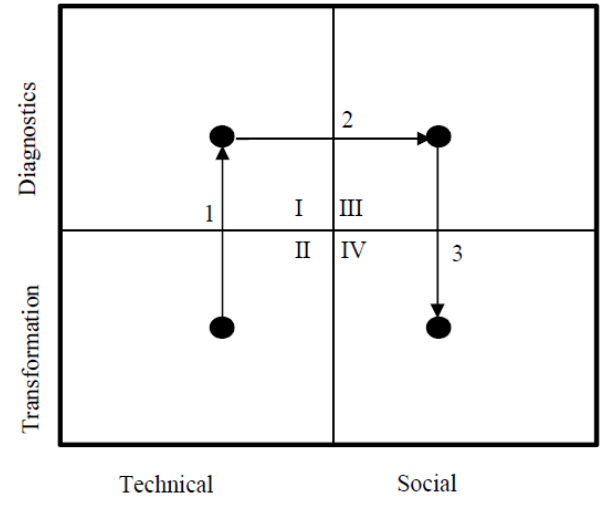
Figure 8. A problem seeking